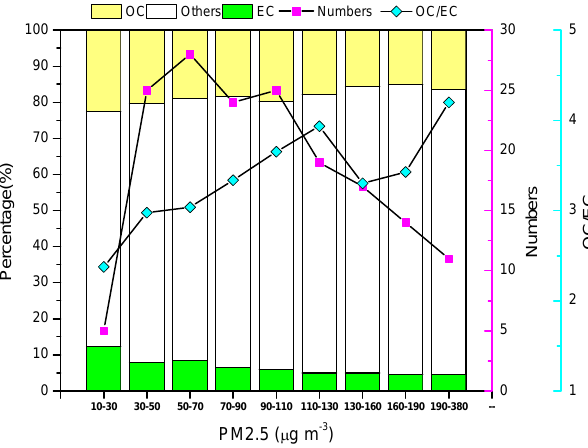
Figure 7. The carbonaceous aerosol mass fractions of ambient PM 2 . 5 and OC / EC ratios, classified by PM 2 . 5 concentration from reconstructed data measured in areas highly affected by anthro- pogenic sources (i.e., urban and suburban sites) in China. Numbers of data points by PM 2 . 5 level are also